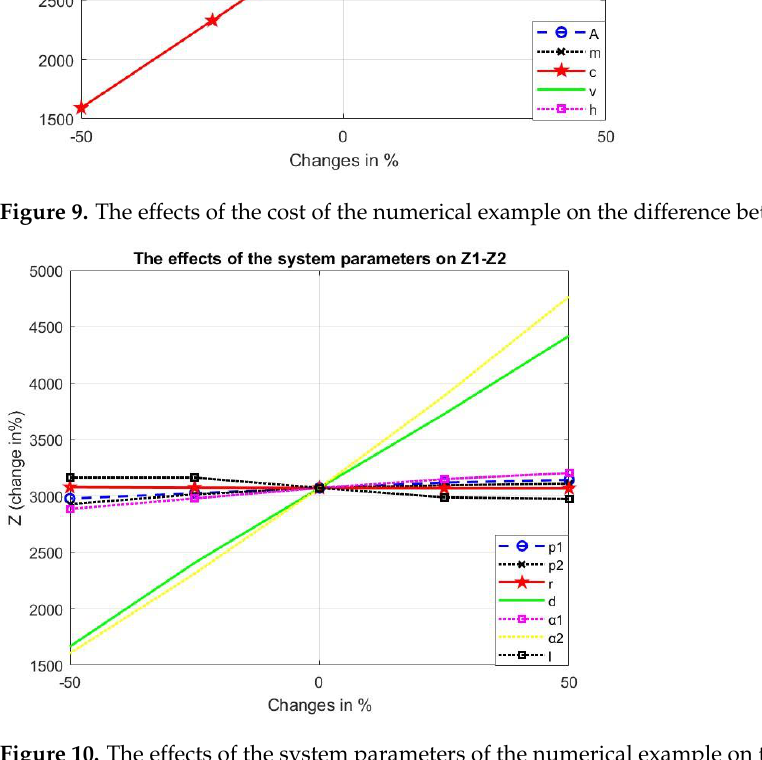
Figure 10. The effects of the system parameters of the numerical example on the difference between the two models.